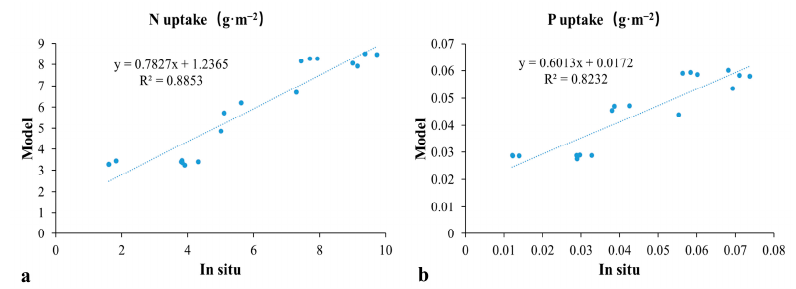
Figure 9. The N ( a ) and P ( b ) uptake rate of quadrant scatter diagrams between the RIPAM model and in situ survey.